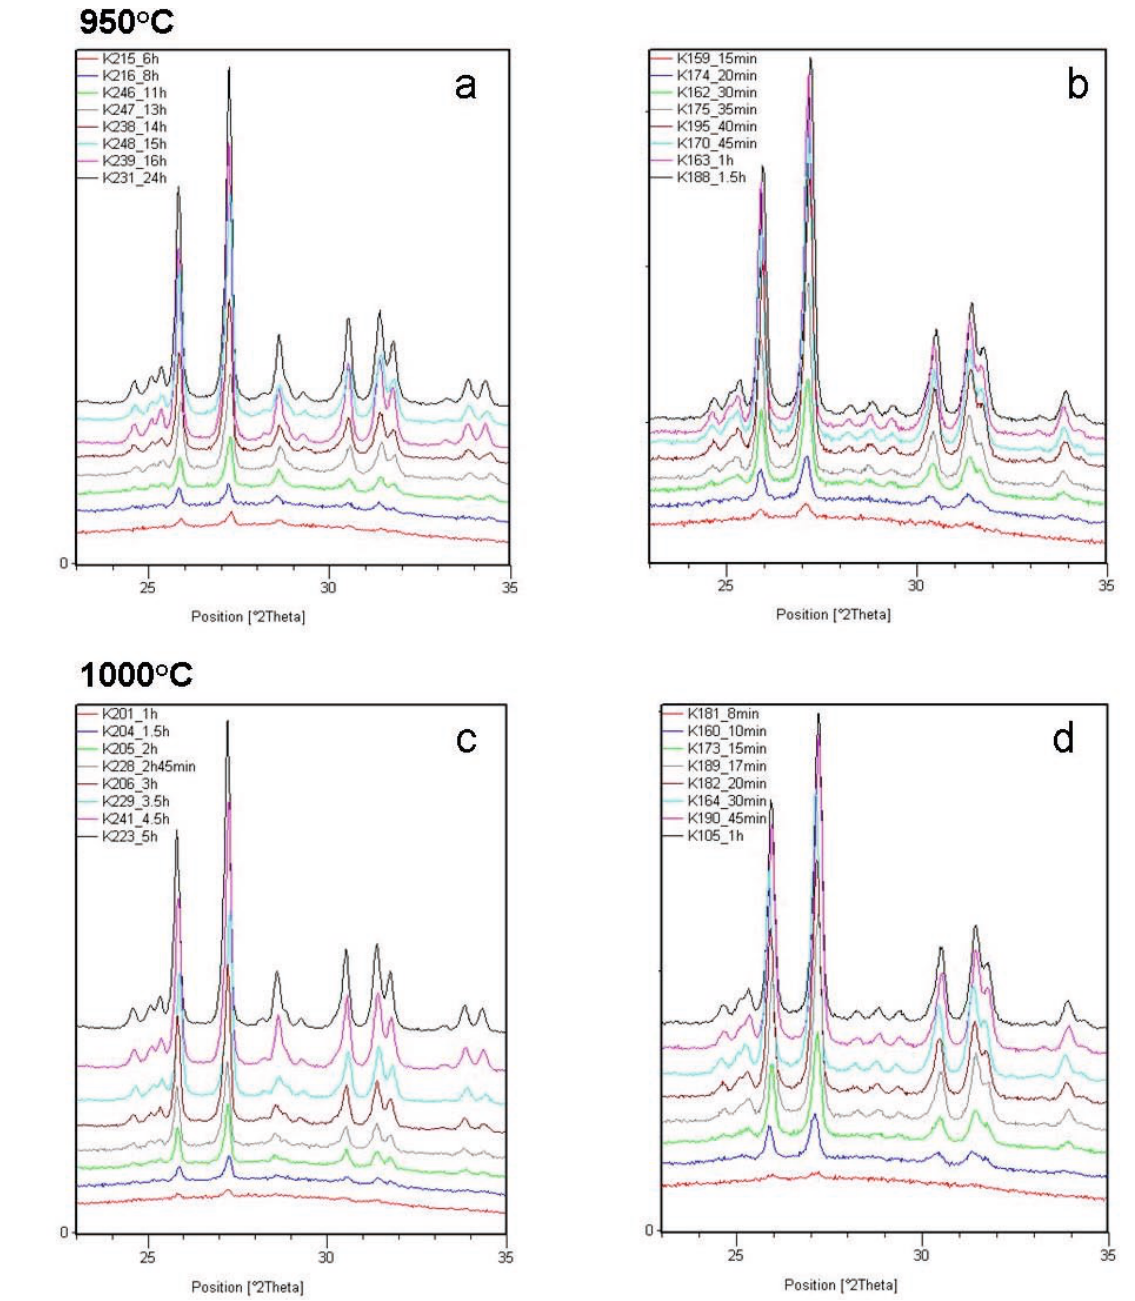
Figure 2. XRD patterns of the products prepared from P1 (a, c) and P2 (b, d) at different reaction temperatures and